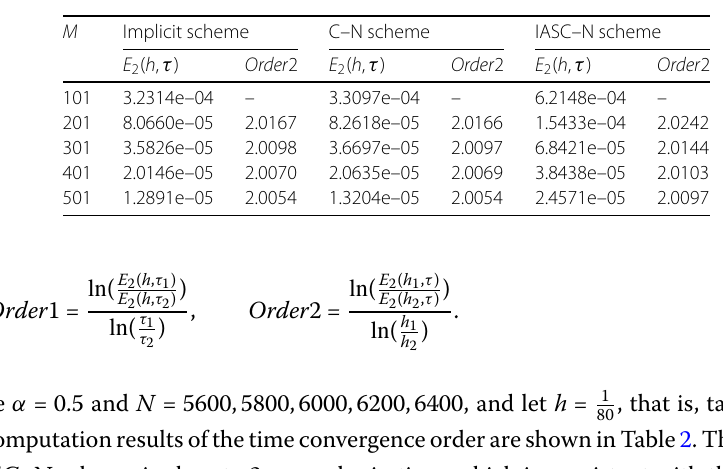
Table 2 Scheme errors and time convergence orders ( α = 0.5, h = 1 N